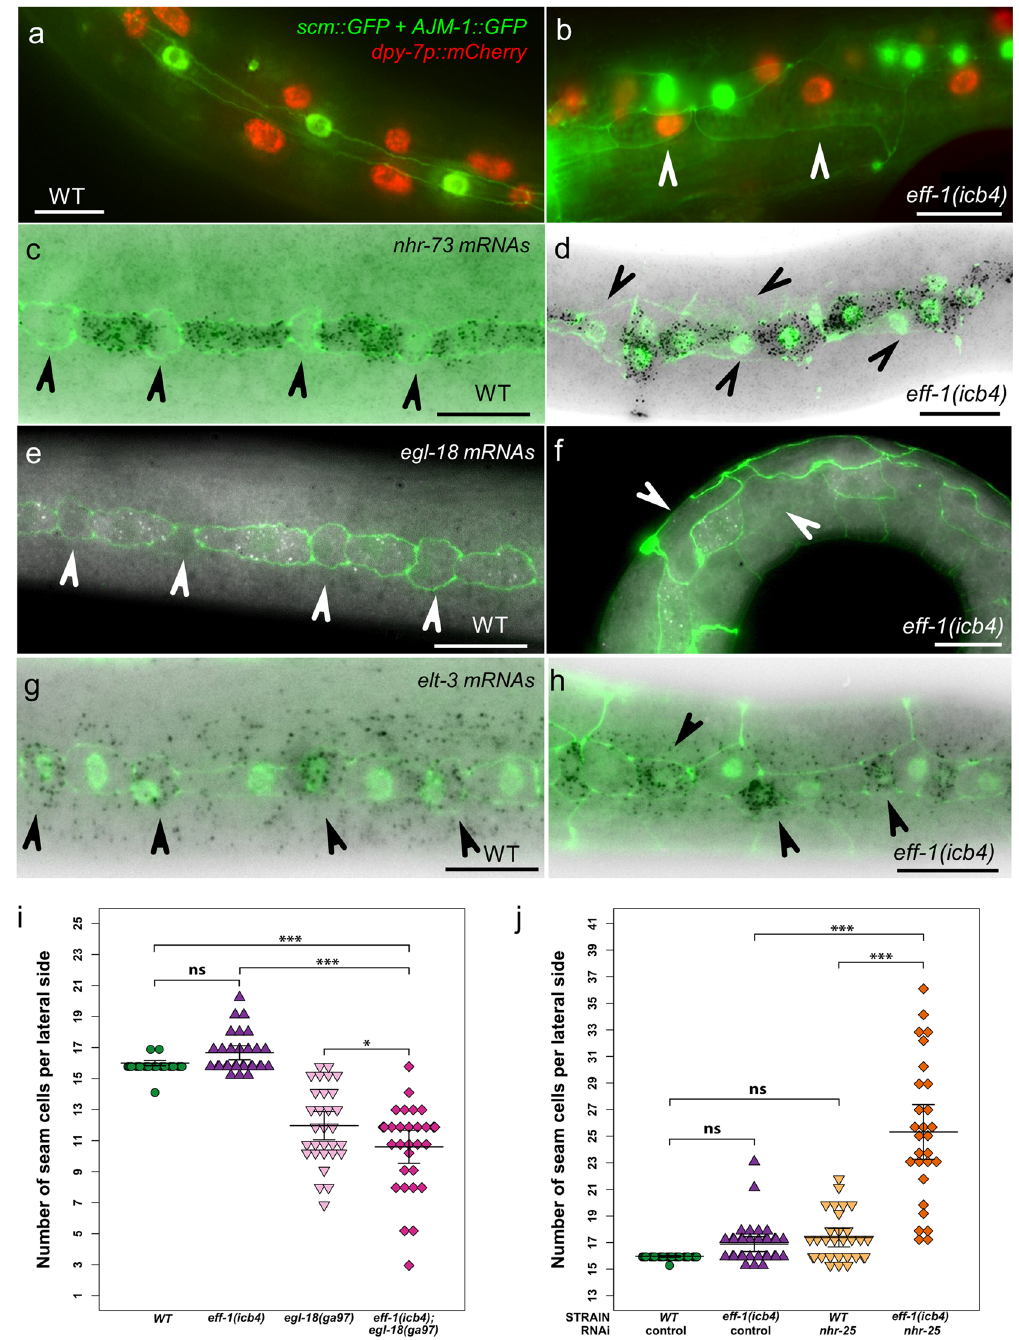
Figure 6. Anterior seam cell daughters still differentiate in the absence of fusion. ( a–b ) Representative images of wild- type and eff-1(icb4) animals expressing seam cell and hypodermal markers. eff-1(icb4) animals have epidermal cells showing ectopic AJM-1::GFP expression due to lack of fusion, while these cells show dpy-7 marker expression (marked by arrowheads). ( c–h ) Representative smFISH images of nhr-73 ( c – d ), egl-18 ( e – f ) and elt-3 ( g – h ) in wild-type and eff-1(icb4) animals. Note that posterior cells express seam cell-specific markers ( nhr-73, egl-18 ) in eff-1 mutants and anterior cells express the hypodermal marker elt-3 . Seam cells are labelled in green using ajm-1p::ajm-1::GFP and scm::GFP and arrowheads point to differentiating cells. ( i ) Seam cell number increase in eff-1 depends on EGL-18. One-way ANOVA shows there is a significant effect of strain on SCN (F (3, 116) = 67.4, p = 2.2 × 10 –16 ). Post hoc Tukey HSD tests showed that there is a significant difference in SCN between eff-1(icb4) and double mutant eff-1(icb4); egl- 18(ga97) (p < 1 × 10 −4 , n = 30 animals per strain). ( j ) Seam cell counts in the eff-1(icb4) mutant upon nhr-25 RNAi reveal synthetic interaction between eff-1 and nhr-25 . One-way ANOVA shows there is a significant effect of strain on SCN (F (3, 117) = 67.01, p = 2.2 × 10 –16 ). Post hoc Tukey HSD tests showed that there is a significant difference in SCN between nhr-25 knockdown in eff-1(icb4) animals and control RNAi in eff-1(icb4) animals or nhr-25 knockdown in wild-type ( p < 1 × 10 −4 , 28 ≤ n ≤ 33 per strain). Error bars in i and j indicate 95% confidence intervals. Scale bars in a-h are 10 µm. Panels a-h were created using Fiji 2.0.0 44 and panels i-j using R version 4.0.3 45